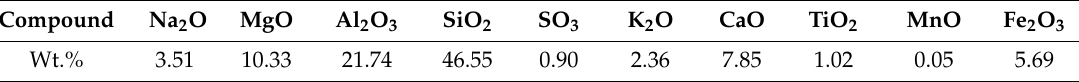
Table 3. The oxide composition of FD measured by XRF.